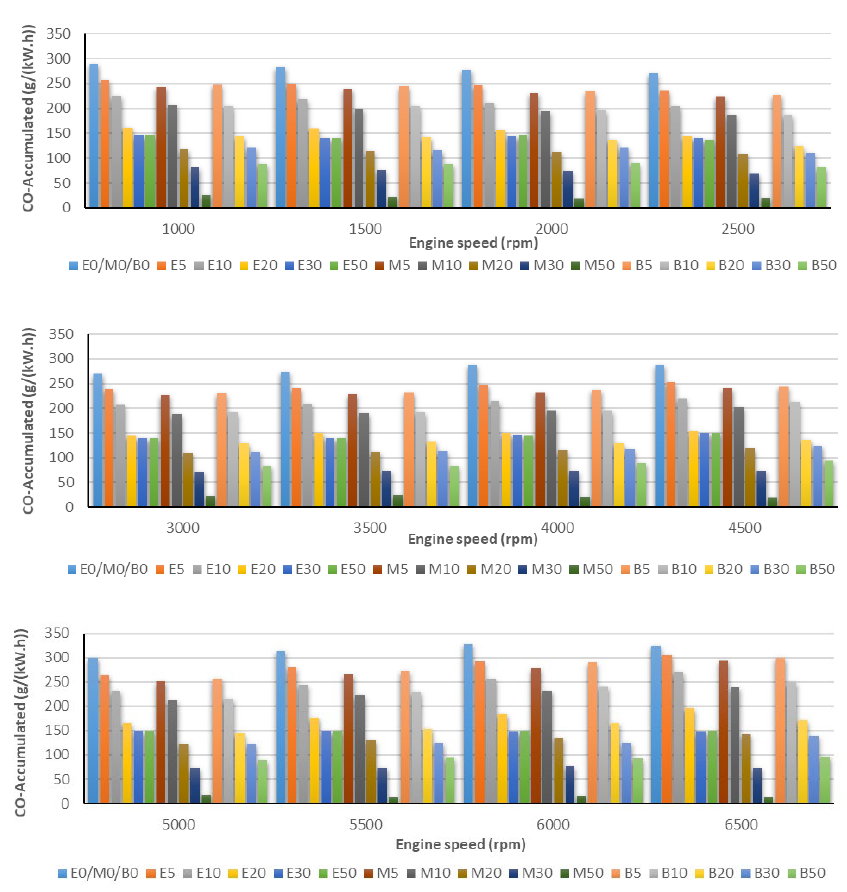
Figure 4. The results for CO emissions obtained from blended alcohol fuels and net